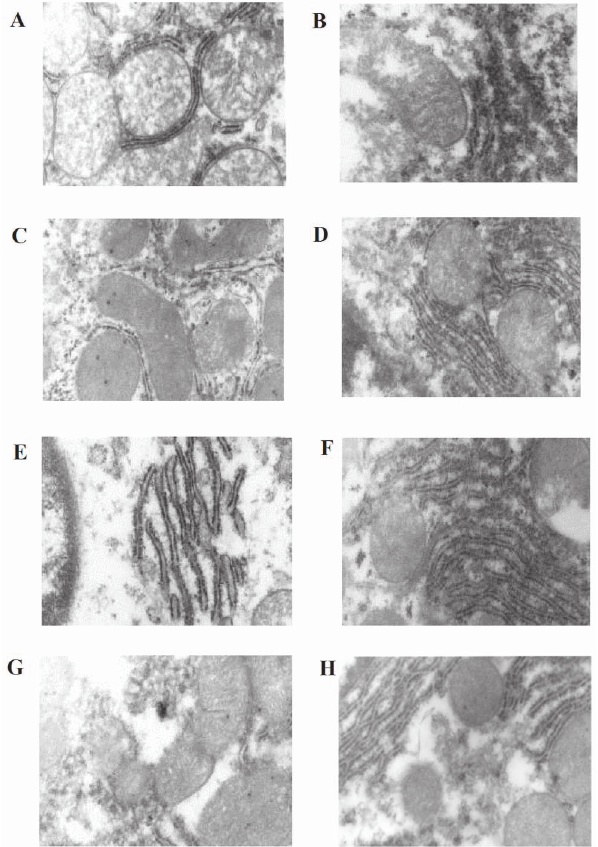
Figure 1. Sections of liver tissue were stained with hematoxylin and eosin. A, control group; B, five weeks exercise-training group; C, five weeks stimulating group.